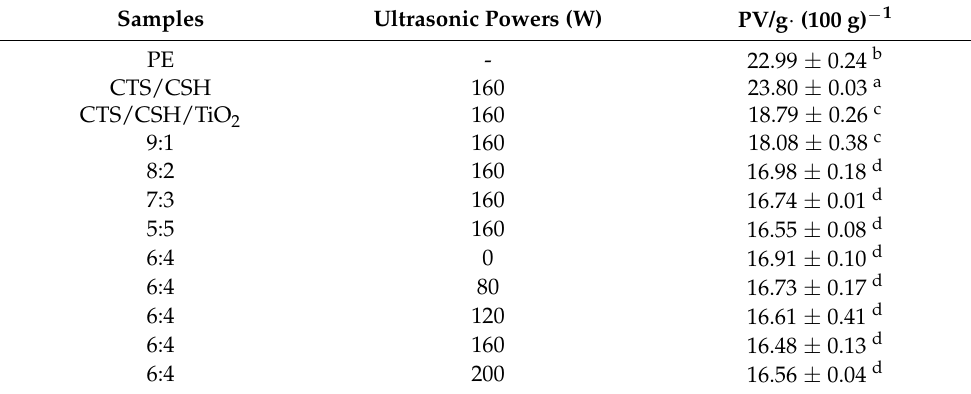
Table 5. Oxygen resistances of the CTS/CSH, CTS/CSH/TiO 2 , and various CTS/CSH/TiO 2 /Gr composite